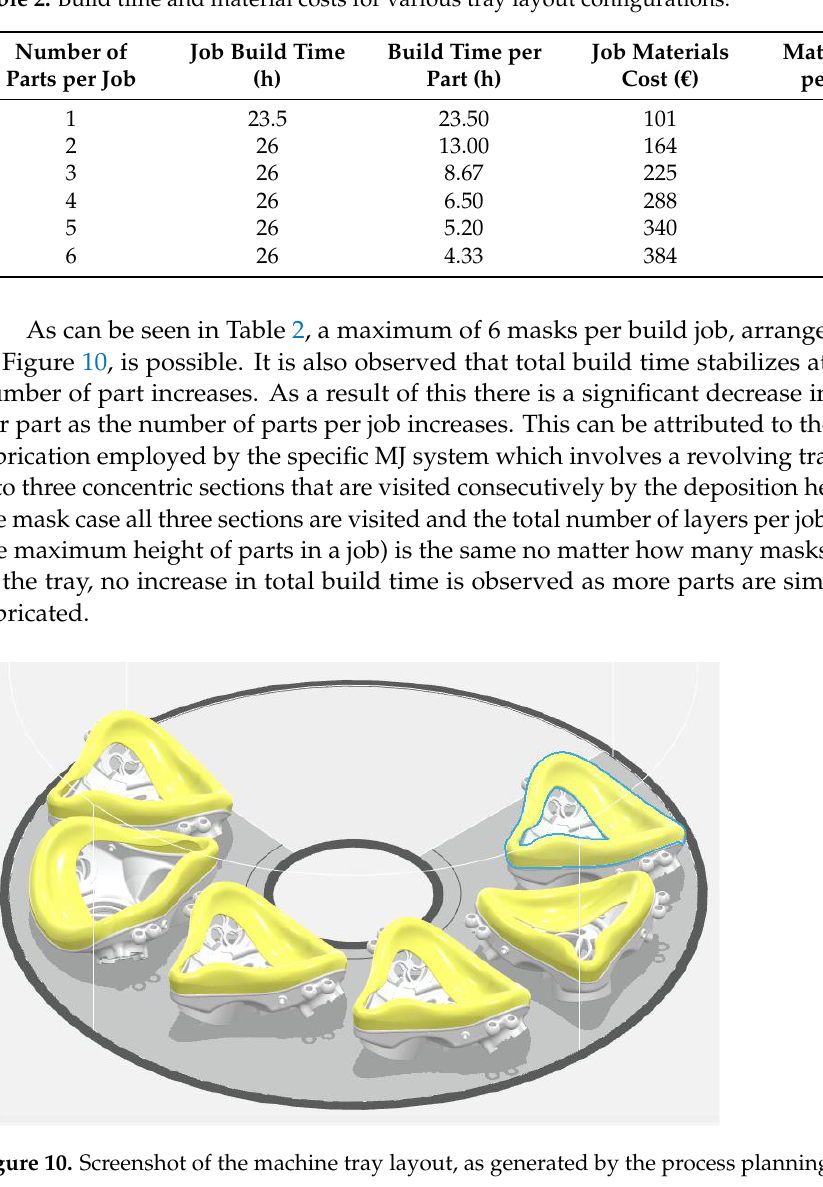
Table 2. Build time and material costs for various tray layout configurations.